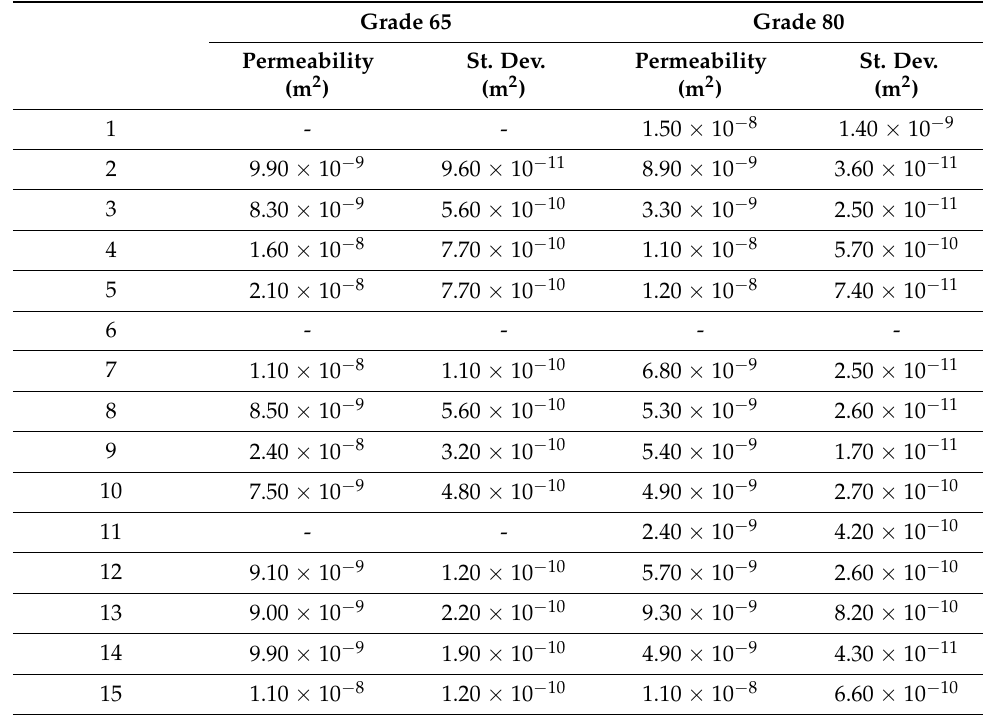
Table A14. Permeability of CFF samples of Grade 65 and 80 from supplier A.